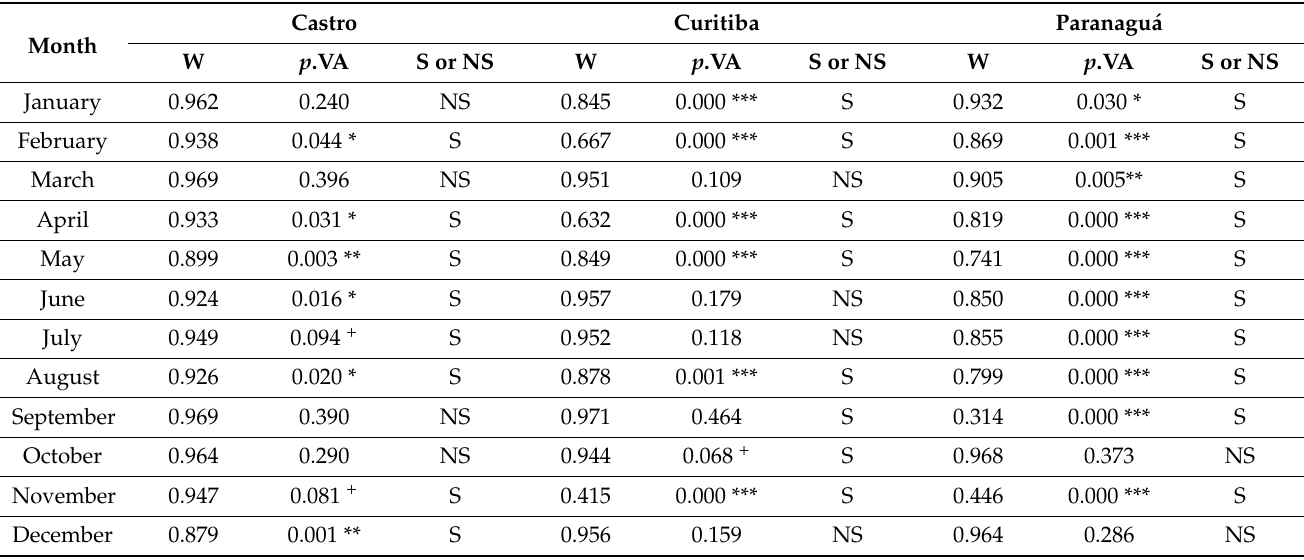
Table 7. Shapiro–Wilk parametric test on the monthly scale for the meteorological